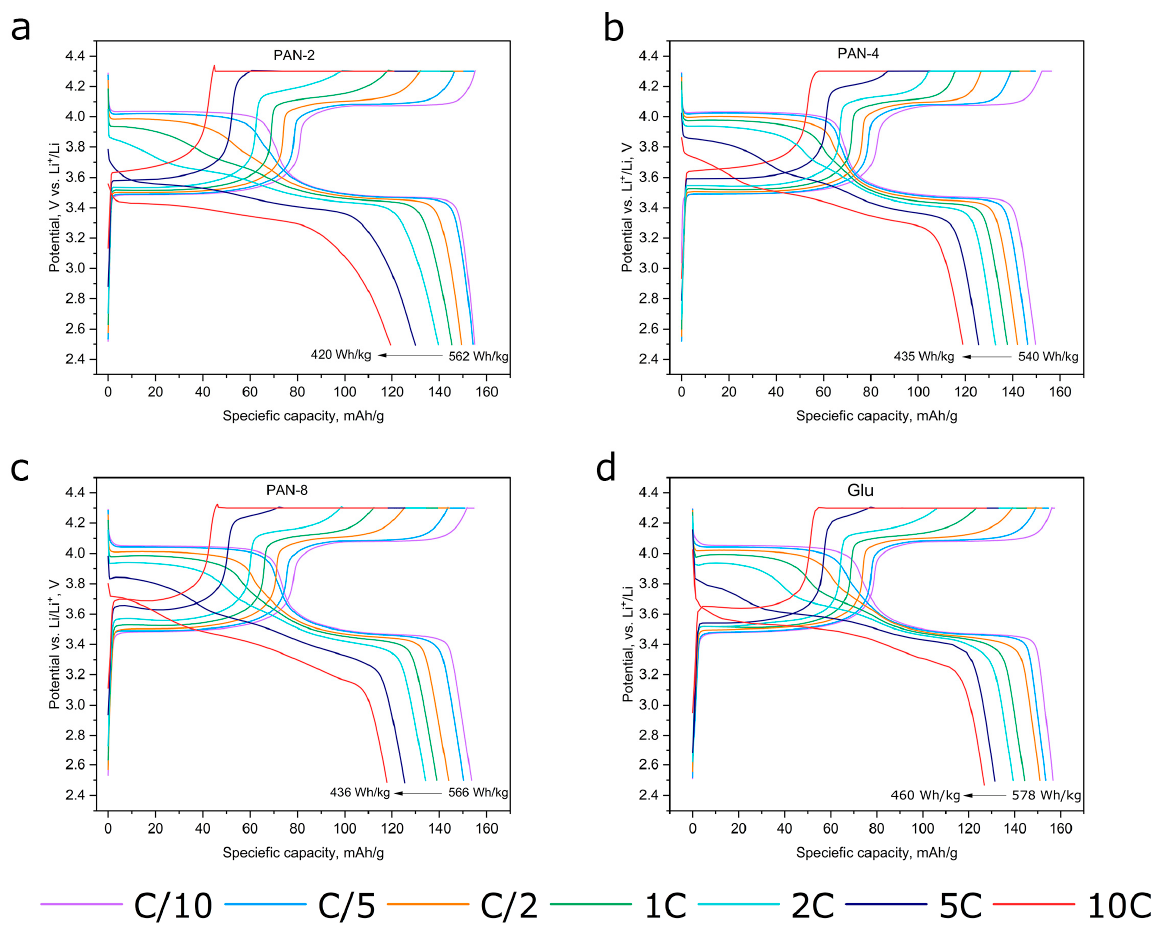
Figure 5. Charge–discharge profiles at C/10–10C rates of PAN-2 ( a ), PAN-4 ( b ), PAN-8 ( c ) and Glu ( d ).